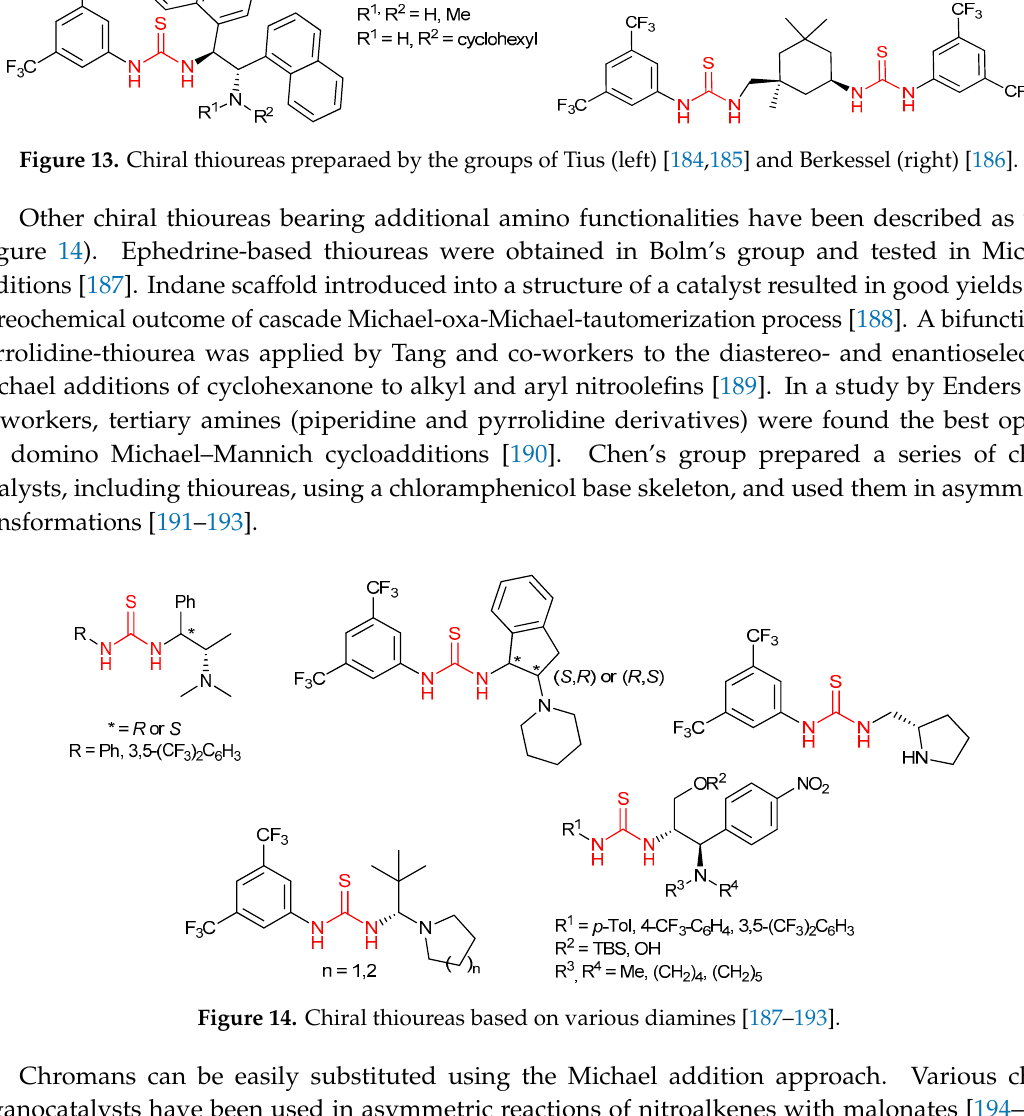
Figure 11. A chiral bis-thiourea prepared by Nagasawa and co-workers [173]. Other chiral diamines have been converted to thioureas as well. Organocatalysts bearing multiple hydrogen bond donors—chiral diaminocyclohexane and 1,2-diphenylethylenediamine fragments (Figure 12), the latter converted into sulfonamide, were prepared by Wang and co-workers and appeared highly efficient in asymmetric Michael addition as well as nitro-Mannich reaction [176,177]. Among chiral thioureas containing tertiary amines tested in Michael additions of 3- substituted oxindoles to maleimides, and cyanoacetates to vinyl sulfones, 1,2- diphenylethylenediamine derivatives led to the highest yields and stereoselectivities (Figure 12) [178,179]. In turn, primary amines of this kind (Figure 12) were found most efficient in asymmetric additions to unsaturated ketones [180,181] and a stereoselective construction of α , α -disubstituted cycloalkanones [182]. A catalyst bearing two 1,2-diphenylethylenediamine fragments (Figure 12) was used in a tandem asymmetric Michael/cyclization reaction of 4-hydroxycoumarin and nitroalkanes, albeit with moderate yields [183]. Figure 12. Chiral thioureas based on 1,2-diphenylethylenediamine [176–183].